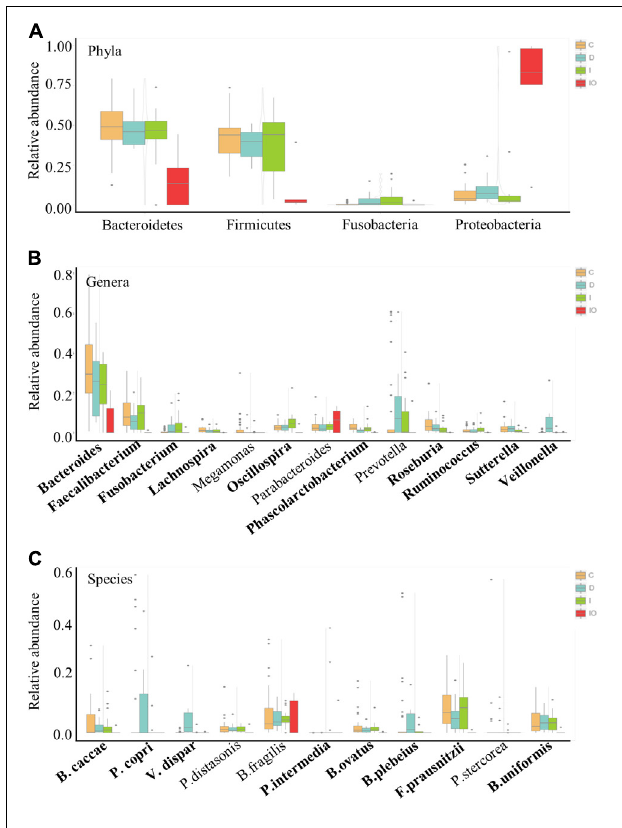
FIGURE 4 | Relative abundance of the representative phyla, genera and species for group comparison. Representative high abundance microbes for all of the clinical groups in this study at the phyla (A) , genera (B) , and species (C) levels. C, healthy individuals; D, CRC patients after chemotherapy; I, CRC patients before treatment; IO, CRC patients after surgical